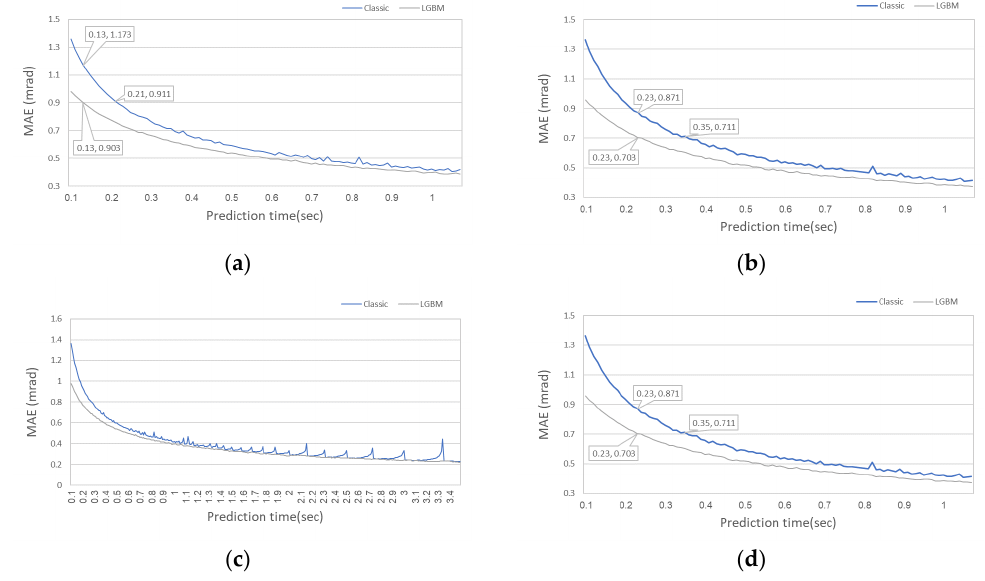
Figure 6. LightGBM compared to classical CA prediction errors vs. prediction time. ( a ) Roll error for prediction time in the range of 0.1–1 s ; ( b ) Pitch error for prediction time in the range of 0.1–1 s; ( c ) Roll error for prediction time in the range of 0.1–3.5 s; ( d ) Pitch error for prediction time in the range of 0.1–3.5 s.